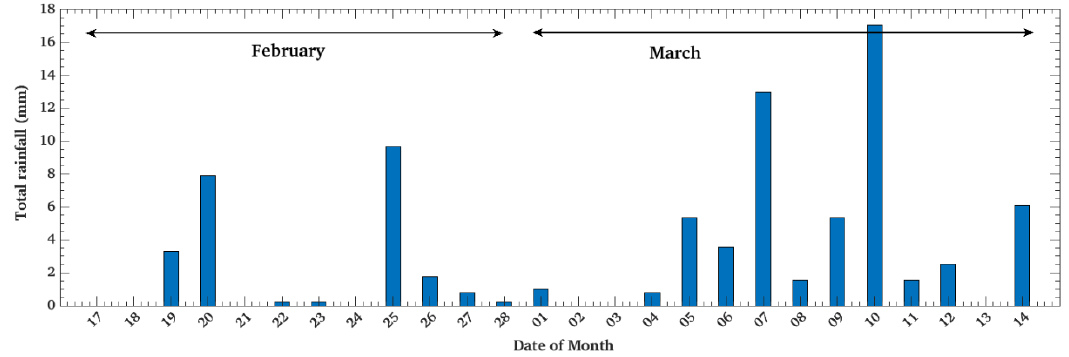
Figure 8. Precipitation (mm / 24 h) recorded at the Huancayo observatory between 18 February and 14 March 2019.